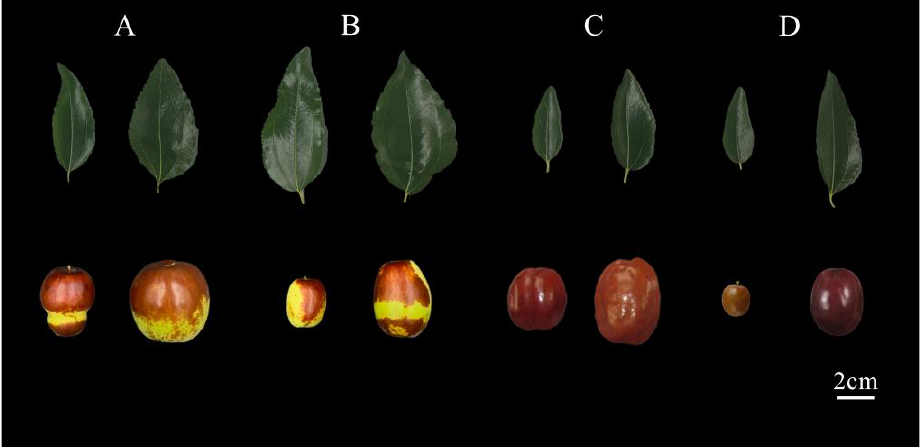
Figure 4. Images of leaves and fruit traits in natural triploids and diploids of jujube. ( A , right) QXPGZ, ( A , left) QXMGZ (jujube diploid control in the sub-region). ( B , right) TGDGHPZ, ( B , left) TGYZGZ (jujube diploid control in the sub-region). ( C , right) JSNYDBZ, ( C , left) JSNYXBZ (jujube diploid control in the sub-region). ( D , right) LXEBCSZ, ( D , left) LXEBCCMZ (jujube diploid control in the sub-region.).